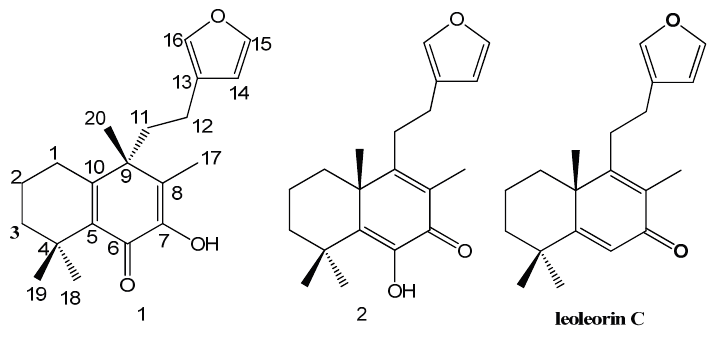
Figure 1. Structures of compounds 1 – 2 and leoleorin C.